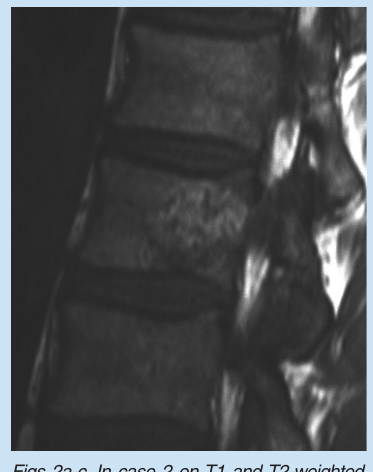
Figs 2a-c. In case 2 on T1 and T2-weighted MR scans the heterogeneous hyperdense haemangioma is noted replacing the left side of the L1 body, pedicle and transverse process. This is best visualised on the trans- verse image on